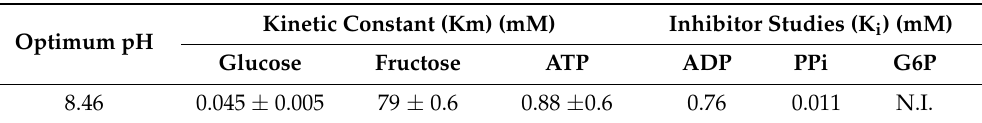
Table 1. Kinetic characteristics of recombinant M. nipponense hexokinase.